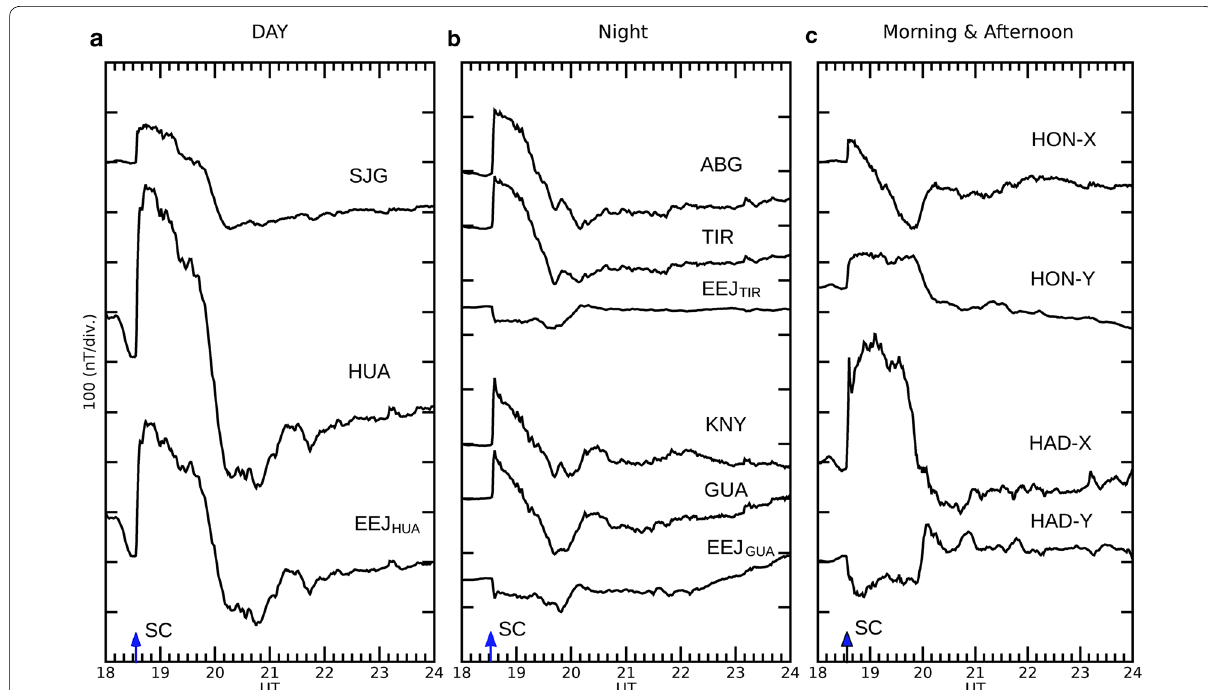
Fig. 3 a X-component of the magnetic fields at the low latitude (San Juan, SJG) and equator (Huancayo, HUA) in the American zone located on the dayside (1330 MLT) when the geomagnetic storm occurred on 22 June, 2015. The EEJ HUA denotes the equatorial electrojet defined as the difference between X HUA and X SJG . b Same parameters for the low latitude (Alibag, ABG) and equator (Tirunelveli, TIR) in the Indian zone located in the midnight (00–02 MLT) and for the low latitude (Kanoya, KNY) and equator (Guam, GUA) in the western Pacific zone, located in the pre-dawn (03–05 MLT). c X and Y components of the magnetic field at middle latitudes, Honolulu (HON) in the morning (09 MLT) and at Hartland (HAD) in the evening